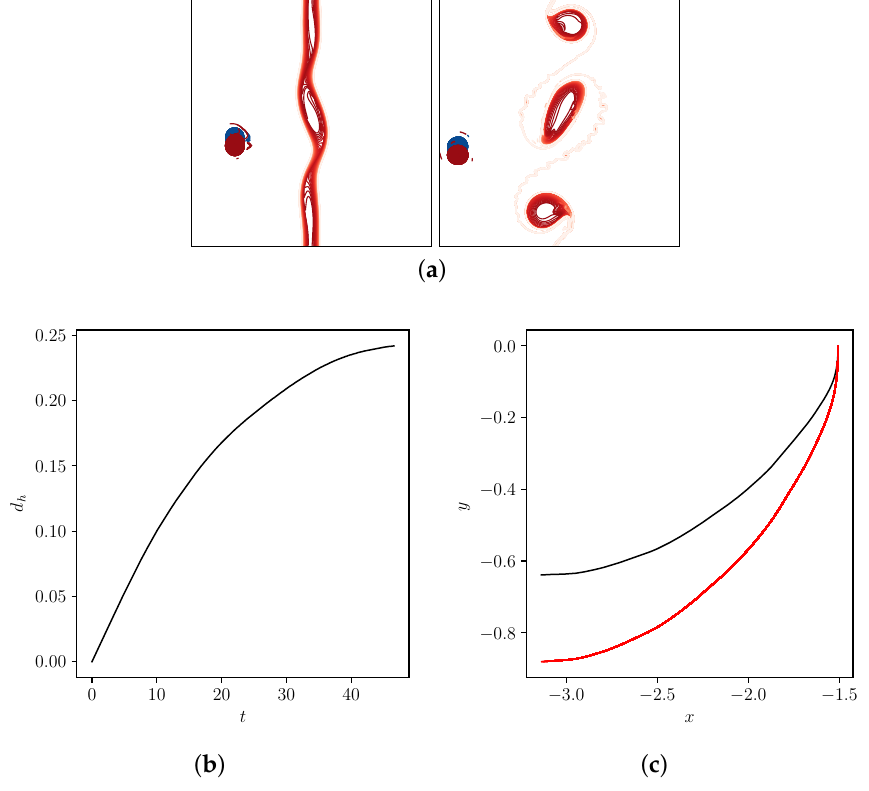
Figure 19. Case 7: effect of reversing the vortex PV. All parameters are otherwise the same as in the default case 1. ( a ) top view of the flow showing contours of buoyancy and PV at t = 20 and 36 from left to right; ( b ) horizontal distance between the vortices d h versus time; ( c ) trajectories of the vortex